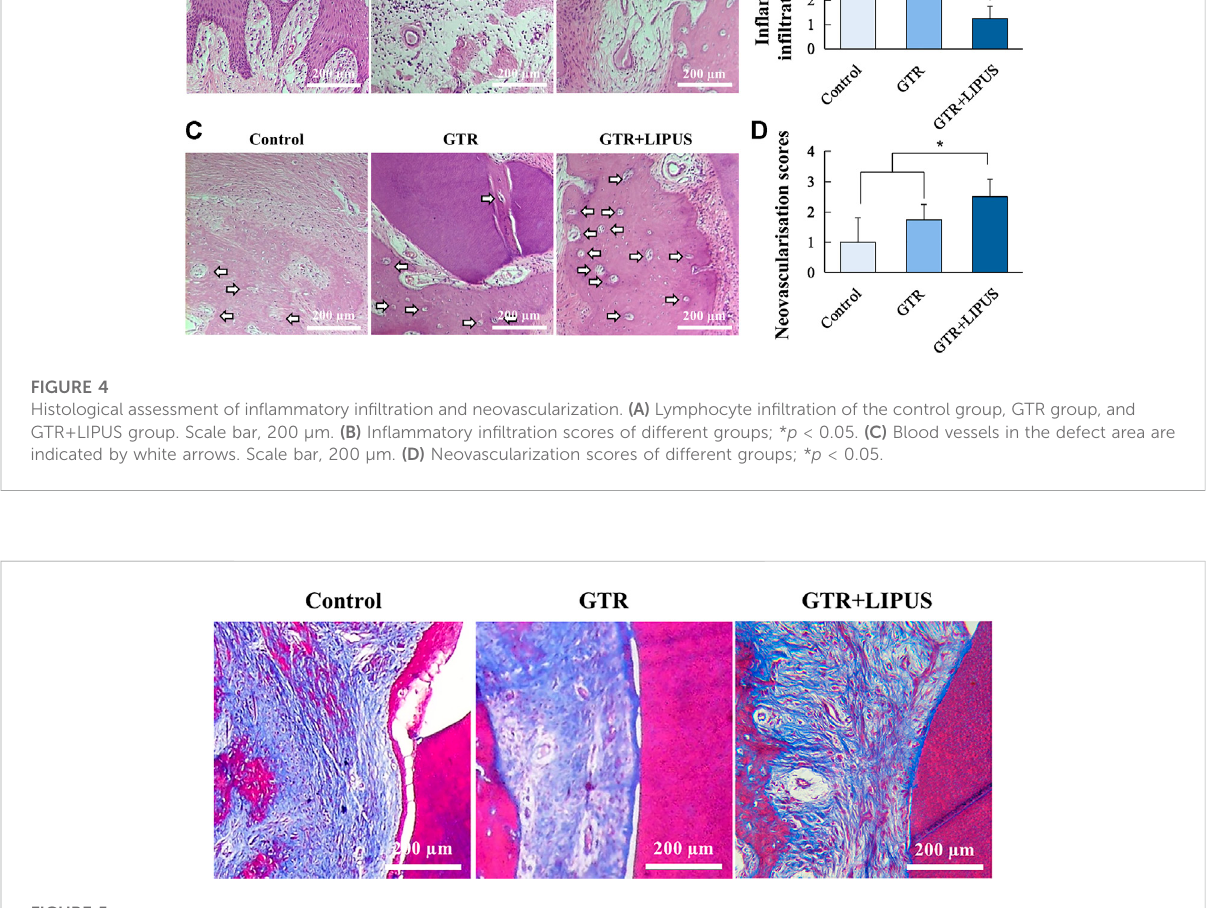
FIGURE 5 Histologicalassessmentofperiodontalattachment.Masson ’ strichromestainingofthecontrolgroup,GTRgroup,andGTR+LIPUSgroup.Scale bar, 200 μ